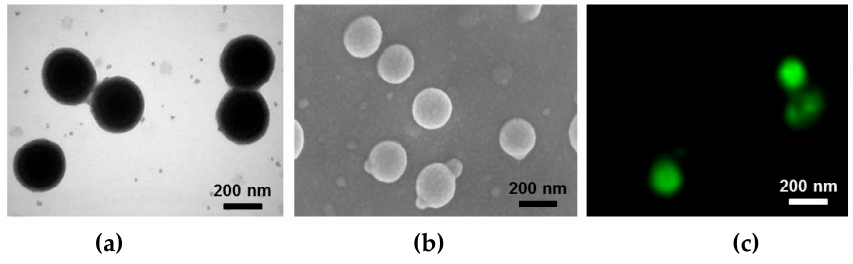
7 of 9 Figure 6. Measurement of the produced protein nanoparticles with different flow rates of GFP: ( a ) TEM images of the controlled particle size; ( b ) dynamic light scattering (DLS) measurement. Table 1. Size control of the protein nanoparticles by changing the flow rate of the His-GFP solution. Entry